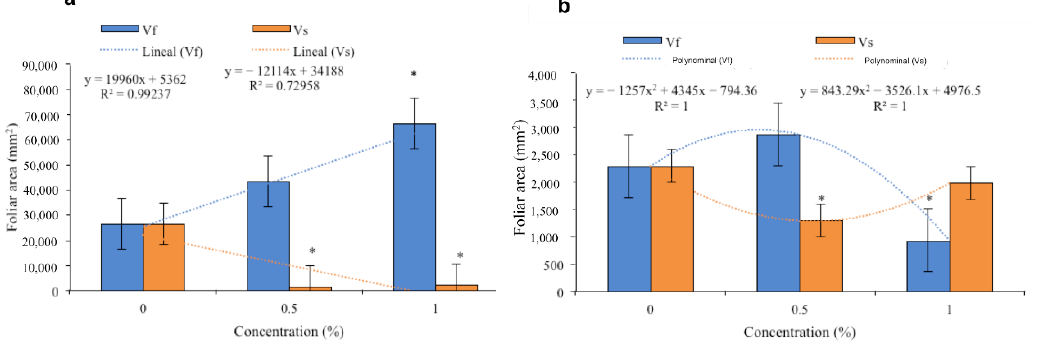
Figure 5. Effects of the aqueous extracts of Verbesina sphaerocephala and Verbesina fastigiata at different concentrations on leaf area in ( a ) Solanum lycopersicum and ( b ) Cucumis sativus . Columns denoted by an asterisk (*) are statistically different from the control. The values represent the average ( n = 20 seedlings); the bars represent the standard error.